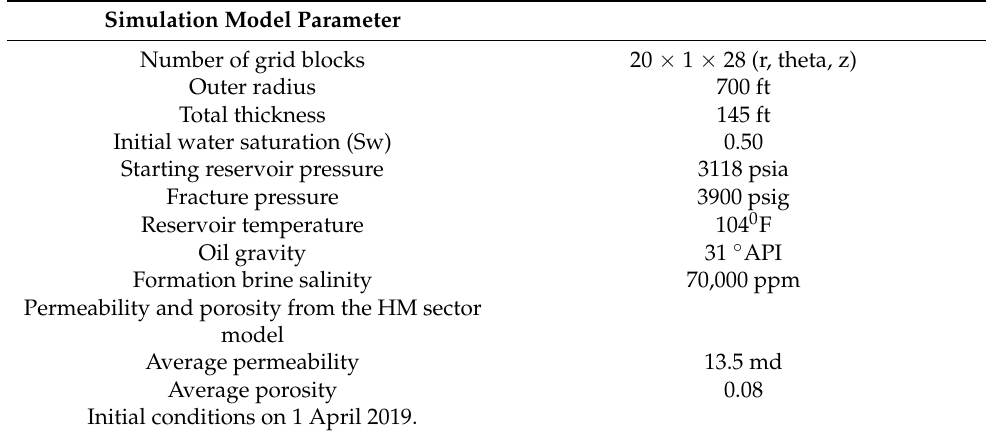
Figure 2. Permeability distribution in the radial model. The number of radial and vertical grid blocks are 20 and 28, respectively. Table 2. Radial simulation model parameters.